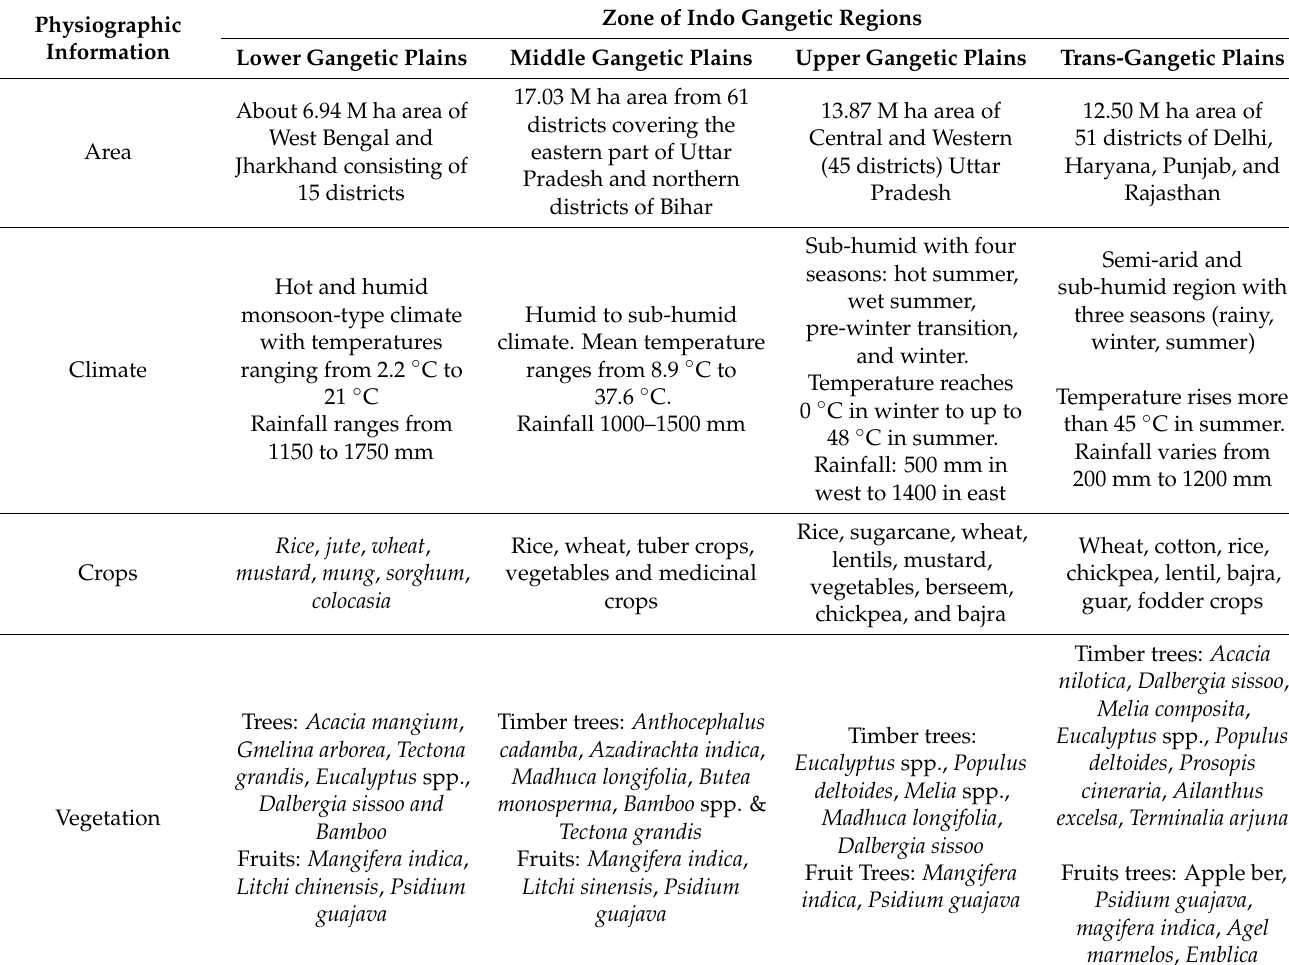
Table 1. Physiographic information of Indo-Gangetic